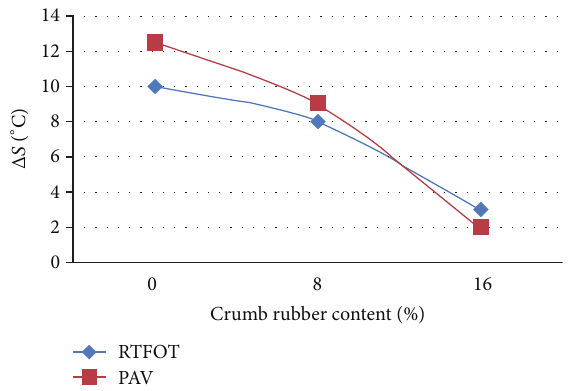
Figure 5: Effect of aging on softening point increment of bitumen binder.